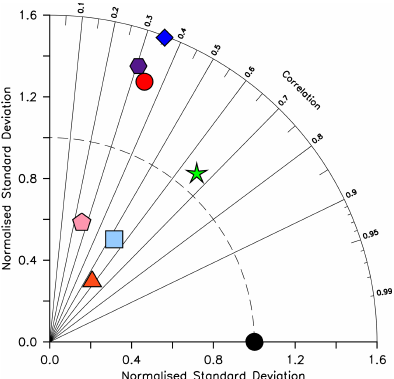
Figure 8. Taylor diagram (Taylor, 2001) of CMIP6 annual average opal flux (in molSim − 2 yr − 2 ) at 2km depth, for the year 2014, nor- malized to the Honjo et al. (2008) dataset. The distance to the ori- gin represents the normalized standard deviation. Normalized cor- relation with observations is read from the azimuthal position. Per- fect agreement with observations is a normalized standard deviation of 1 and a normalized correlation of 1. Models are KMBM3 (red circle), GFDL-ESM4 (green star; Krasting et al., 2018), CESM2 (light blue square; Danabasoglu, 2019), MPI-ESM1.2-LR (pink pentagon; Wieners et al., 2019), CMCC-ESM2 (orange triangle; Lovato et al., 2021), EC-Earth3-CC (blue diamond; EC-Earth Con- sortium, 2021) and IPSL-CM6A-LR (purple hexagon; Boucher et al., 2018). With the exception of KMBM3, the data for all models were obtained by mining the CMIP6 database (https:// esgf-node.llnl.gov/search/cmip6/) using the following search terms: CMIP/expsi/historical/annual output. Data were accessed between 1–5 February